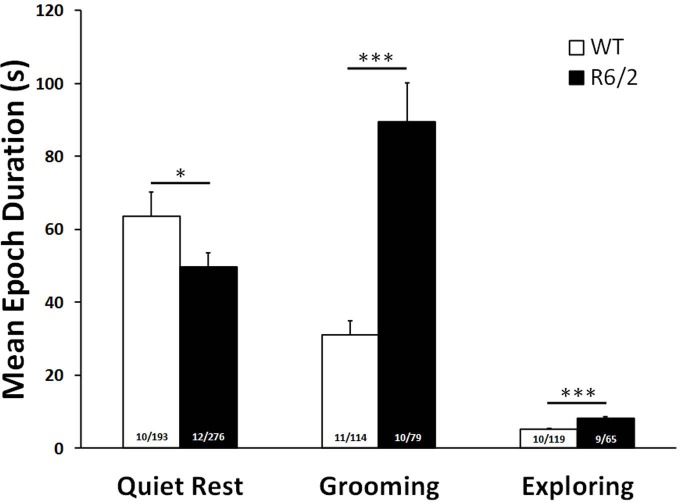
Mean behavioral epoch duration as a function of group and behavior.R6/2 mice engaged in grooming and active exploration for significantly longer periods than WT counterparts. Numbers in each column indicate the number of mice/epoch for each group at each behavior. * p = 0.05; *** p<0.001. Error bars denote SEM.